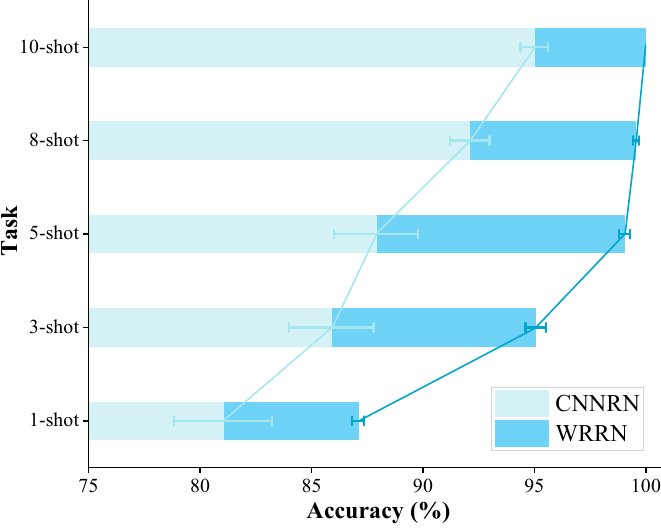
Figure 4. Diagnostic performance comparison on methods CNNRN and WRRN.